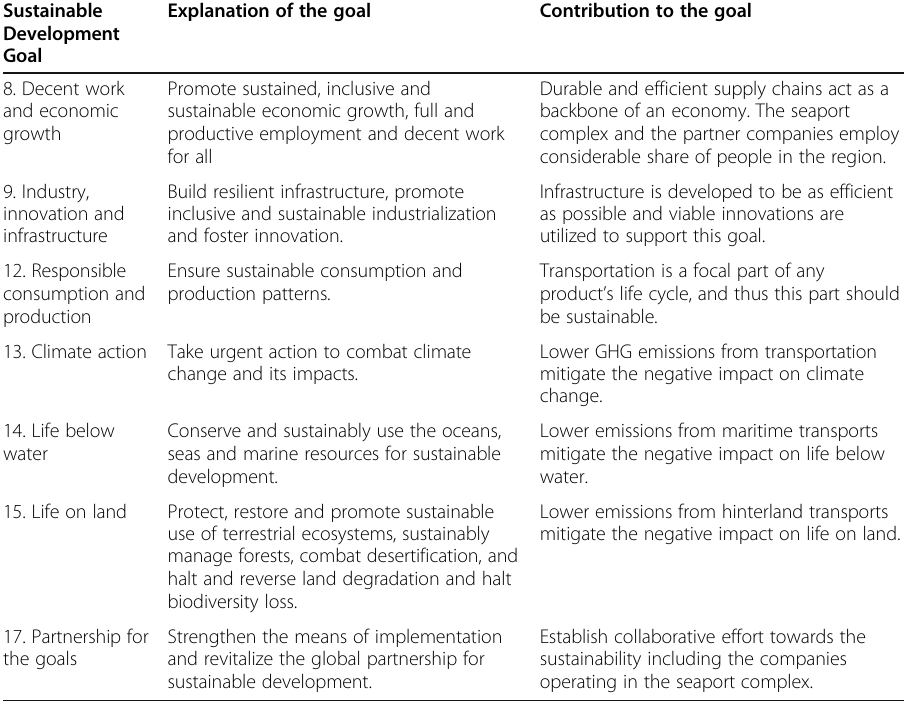
Table 1 Most relevant SDGs for HaminaKotka seaport in terms of mitigating